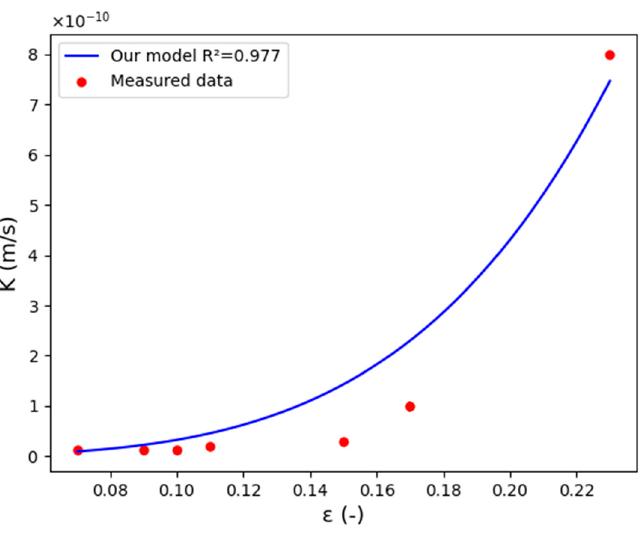
Figure 12. Variation of moisture transfer coefficient with the compressed MCC PH101 powder tablet porosity.